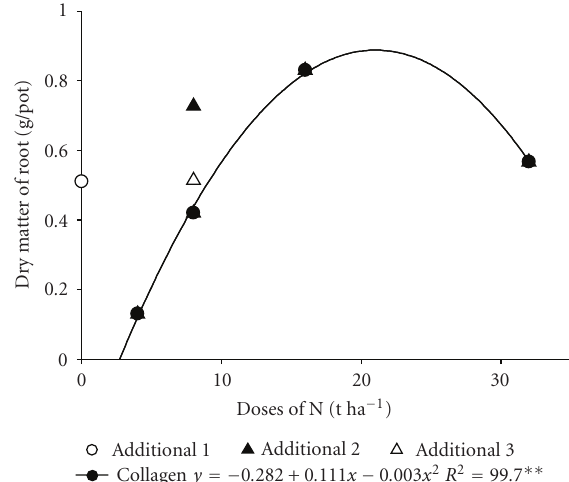
Figure 3: Production of root dry matter in bean plants grown for 84 days, under influence of the studied treatments (collagen: four rates; additional 1: soil without fertilization and without collagen; additional 2: fertilization with mineral N; additional 3: wet blue